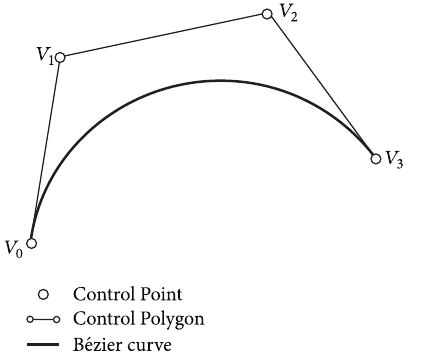
Figure 12: A single cubic B´ezier segment.